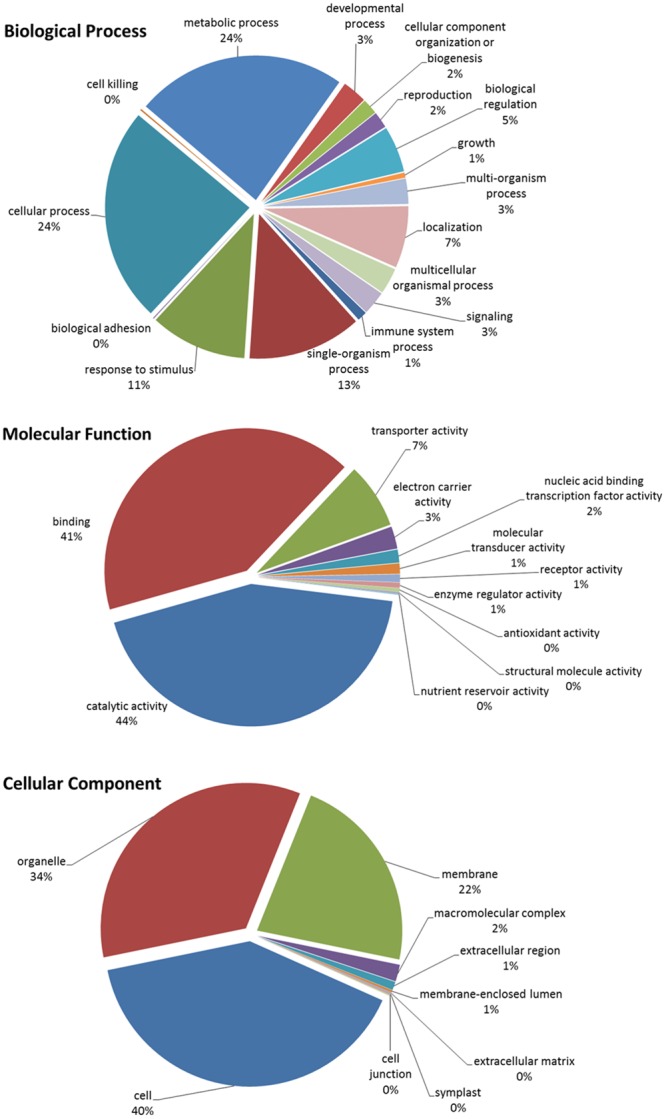
Blast2GO Level 2 gene ontologies of biological process, molecular function, and cellular component for the total up-regulated transcripts in inoculated and uninoculated resistant buffalograss lines compared with inoculated and uninoculated susceptible lines, respectively. Of a total of 1356 differentially up-regulated transcripts, 528 were annotated by Blast2GO.